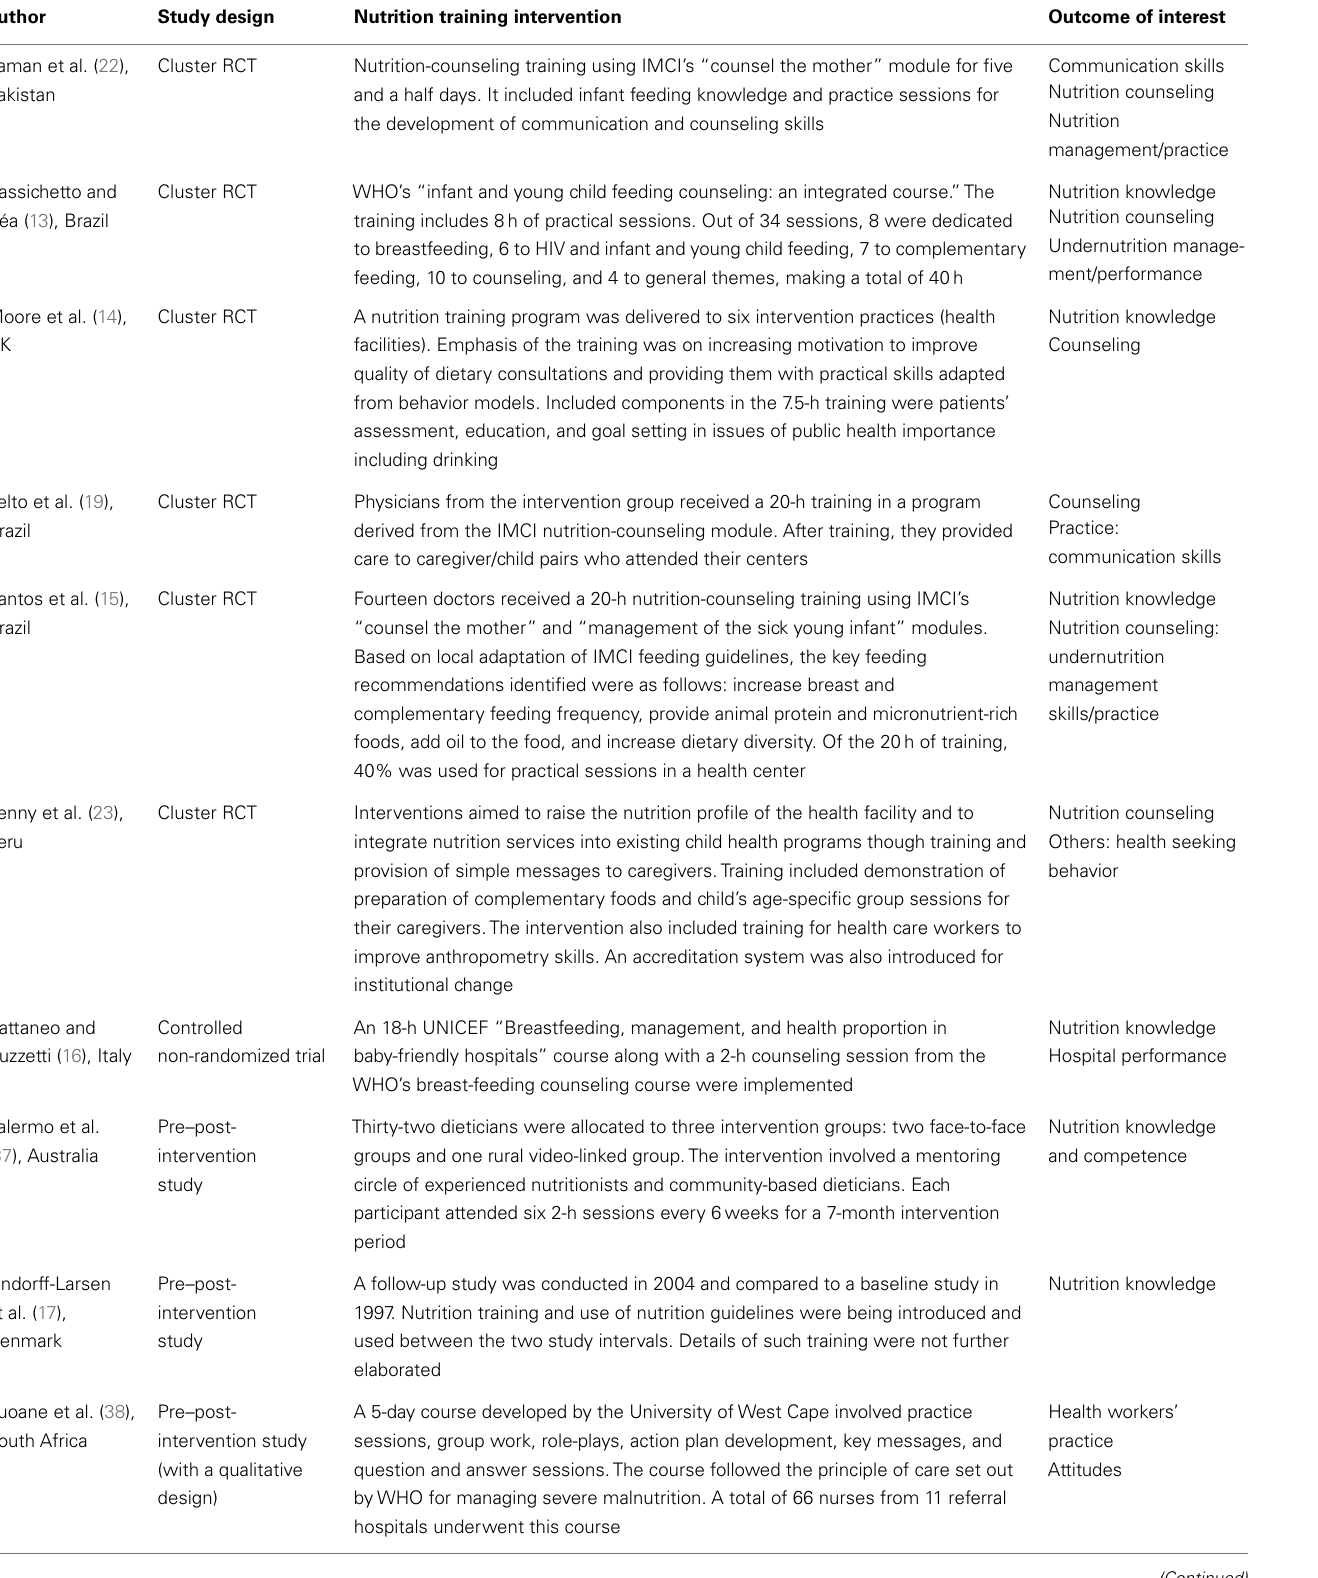
Table 4 | General description of studies included in the